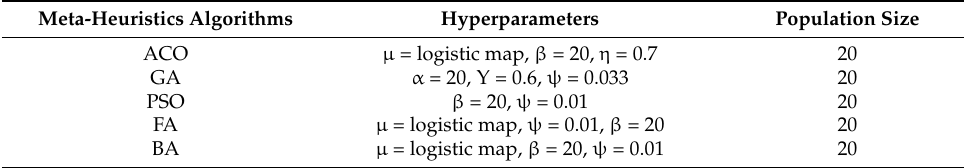
Table 4. Metaheuristics algorithms for feature selection hyperparameter